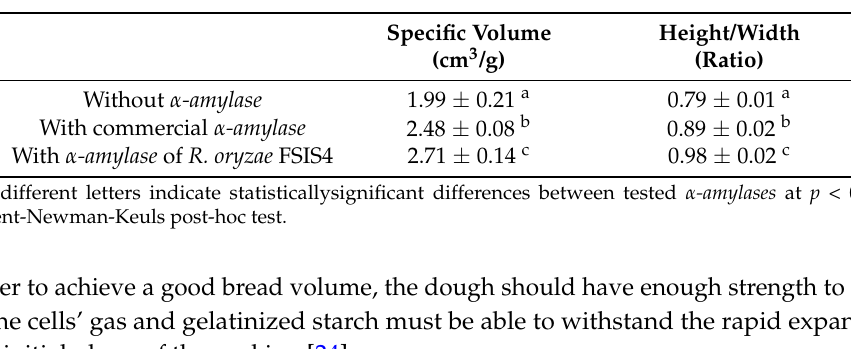
Table 1. Evaluation of α -amylase activity on specific volume and height/width